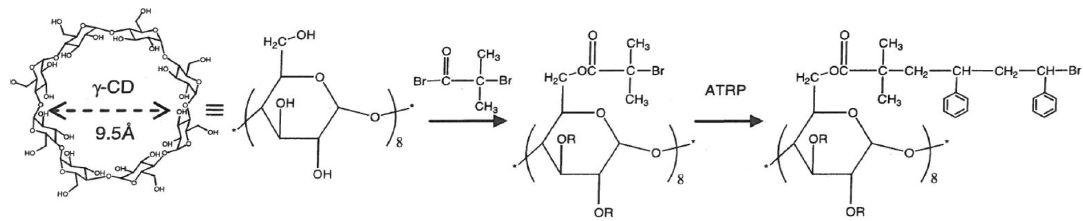
Figure 11. Synthesis of star polymers with a γ –CD core and polystyrene (PS) arms (CD-stars). Reproduced from [14] with permission, copyright Elsevier, 2010.